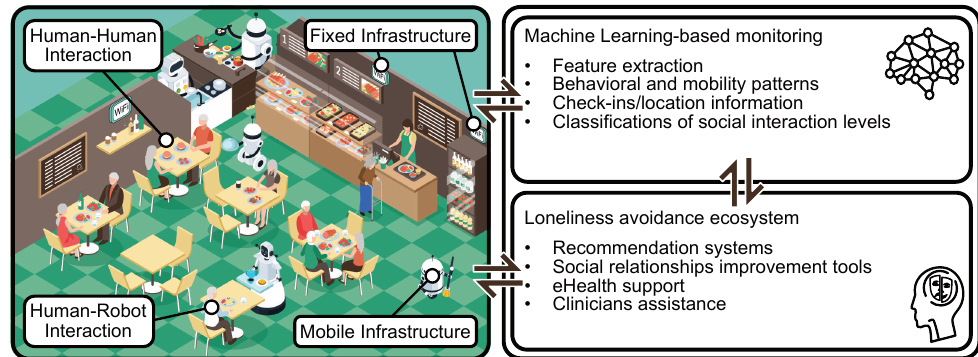
Figure 4. Top-level view of the proposed monitoring and management